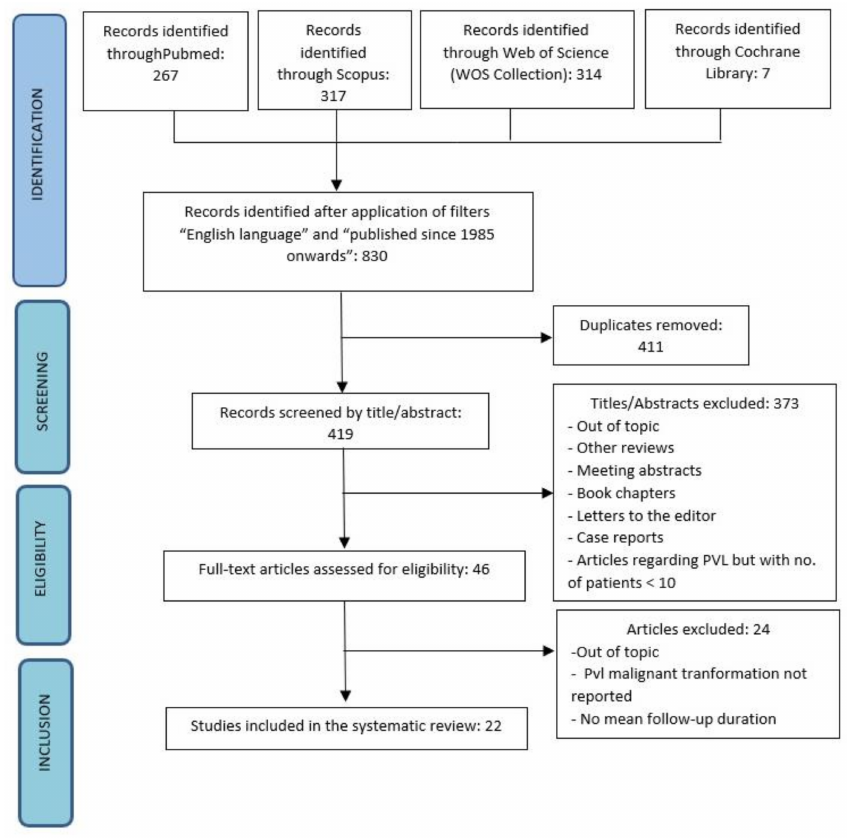
Figure 1. Flowchart of search results and study